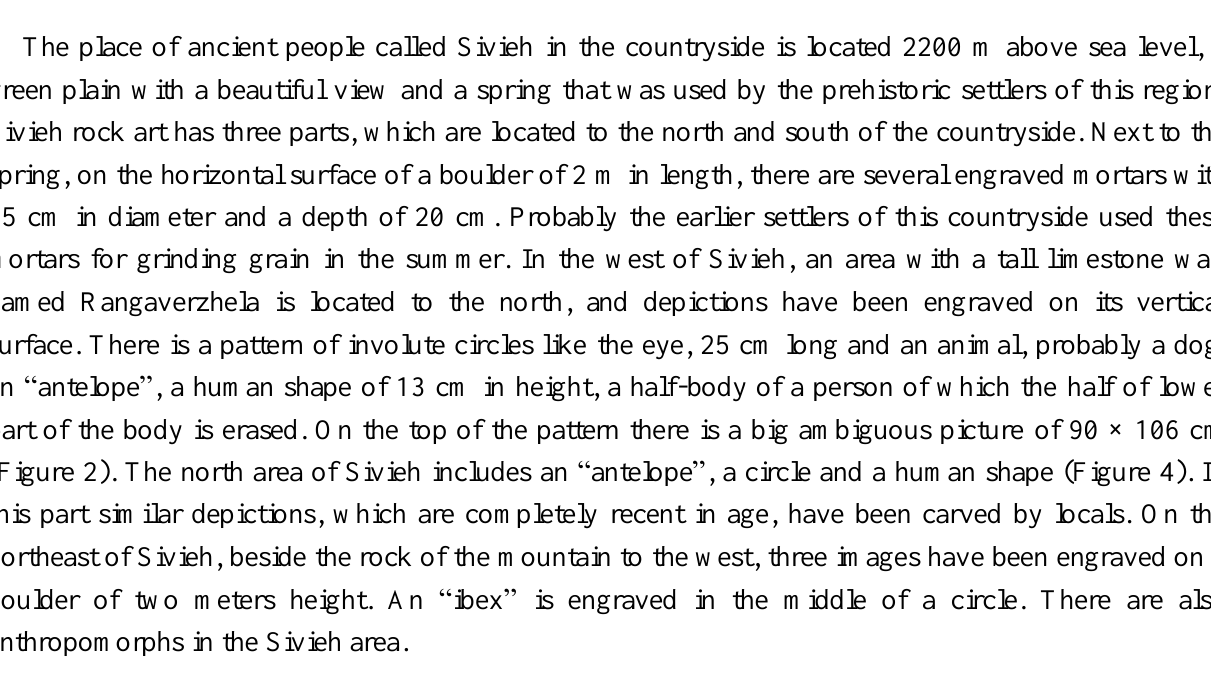
Figure 3 . Sivieh-Havar, a human shape on two wheels holding something in the hand and the cross motif on the